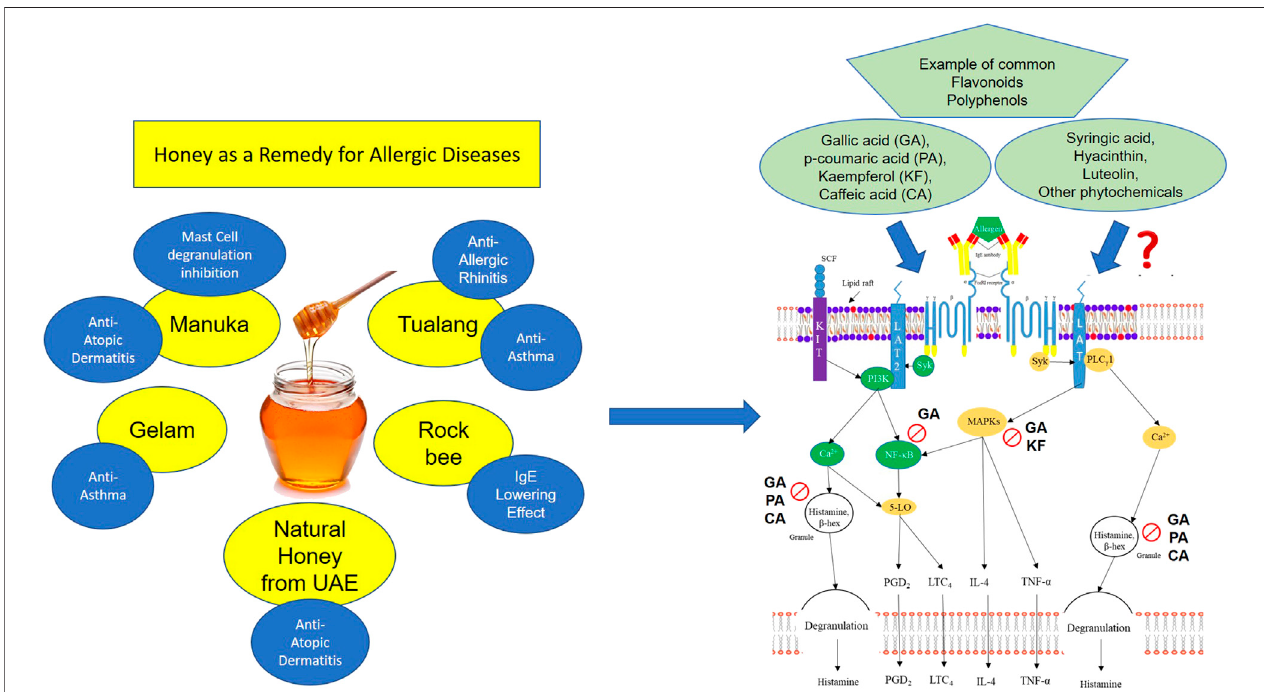
FIGURE1| illustratestheassociationofphytochemicalcompoundspresentinhoney(suchasgallicacid,p-coumaricacid,kaempferol,caffeicacid,andetc.)which exhibit anti-allergic properties and their mechanism of action. Many of these commonly reported phytochemical compounds have been reported to exert their anti- allergiceffectsbyinhibitingvariousmastcelldegranulationsignalingpathways.Forexample,gallicacid(GA)hasbeenreportedtoinhibitNF-kB, MAPKs,andtherelease of granules containing histamine and β -hexosaminidase, which eventually leads to attenuation of allergic